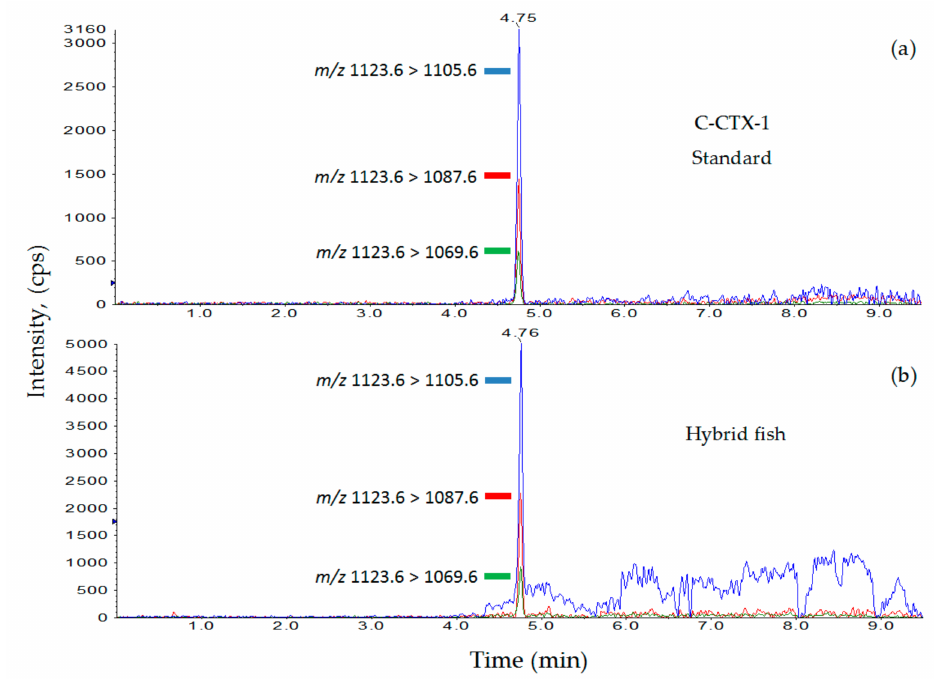
Figure 5. LC-MS / MS (MRM) chromatograms of C-CTX-1: ( a ) C-CTX-1 reference standard of 15 pg on column; ( b ) hybrid fish